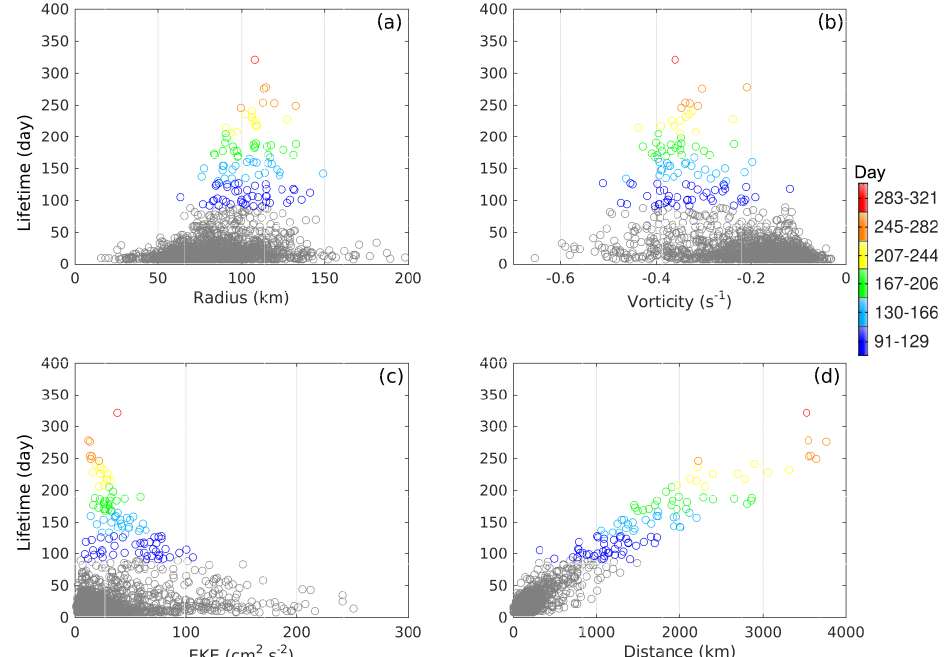
Figure 8. Relationships between eddy lifetime and (a) eddy radius, (b) eddy vorticity, (c) EKE, and (d) propagation distance into the ocean for all anticyclonic eddies with lifetimes longer than or equal to 7d. Long-lived eddies are shown using the color scheme as used in Fig. 7. Eddies with lifetimes shorter than 90d are depicted as gray circles. Note that each circle represents the mean value of every parameter throughout its life period against the eddy